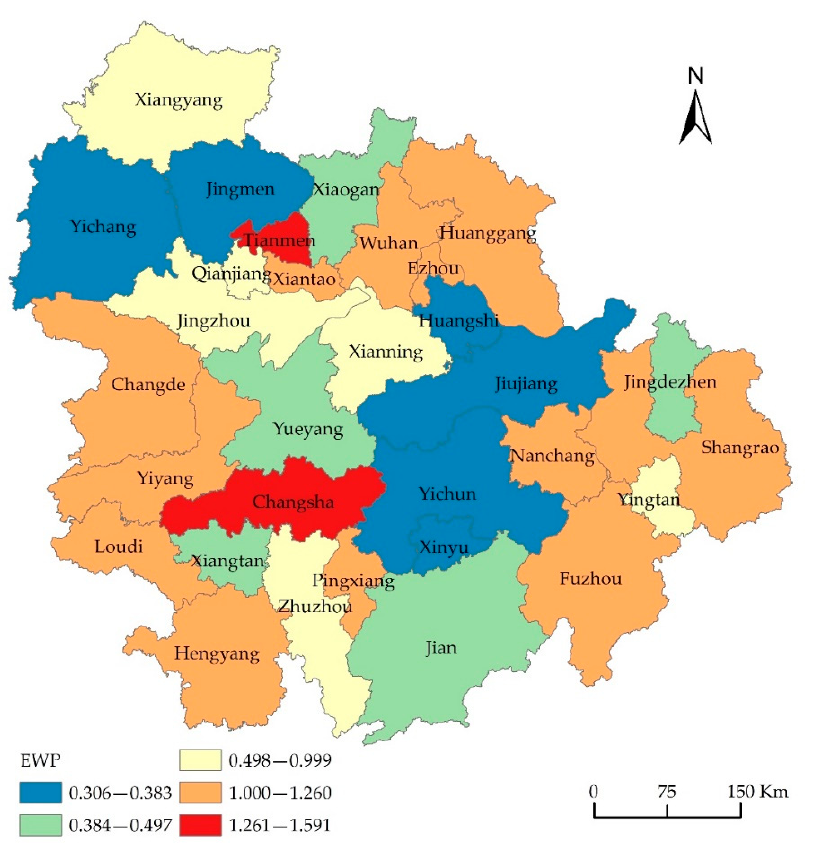
Figure 3. Spatial distribution of EWP in MRYRUA.